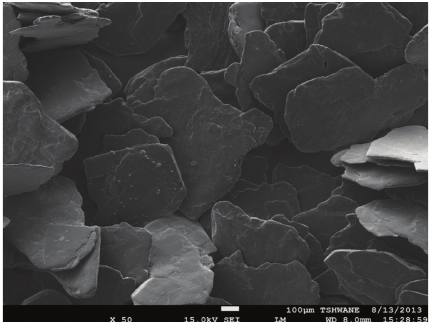
Figure 20: SEM micrograph of EG after the Cone Calorimeter ther- mal analysis.